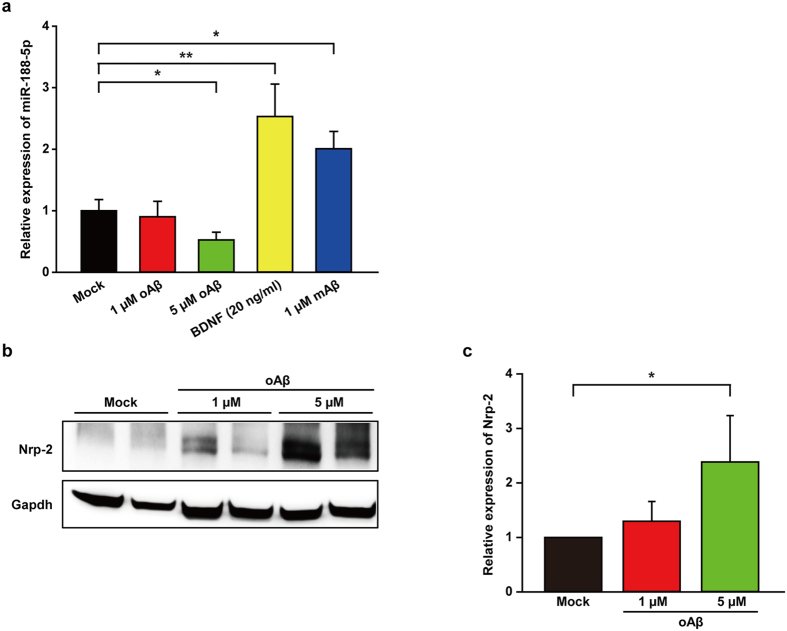
Oligomeric Aβ1-42 reduced the expression of miR-188-5p.(a) miR-188-5p expression was examined by RT-qPCR after treatment with oAβ in primary hippocampal neuron cultures. miR-188-5p expression was significantly reduced by treatment with 5 μM oAβ (n = 11, Mann-Whitney test) compared to vehicle-treated controls. (b) The Nrp-2 protein level was determined in primary hippocampal neuron after oAβ treatment by western blot (1 μM oAβ treatment and 5 μM oAβ treatment for 24 h compared with the control). (c) Quantitative graphs show relative quantification of Nrp-2 protein level normalized to Gapdh (internal control) after 24 h with 1 μM oAβ treatment (n = 3) or 5 μM oAβ treatment (n = 3, one-way ANOVA), compared to control (Mock). Data are represented as the mean ± SEM. *p < 0.05 compared to Mock. oAβ = oligomeric amyloid beta peptide1-42, mAβ = monomeric amyloid beta peptide1-42.